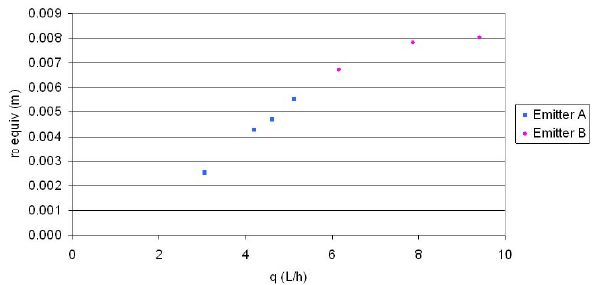
Fig. 3. Spherical-cavity radius, r 0 , versus emitter discharge, q .